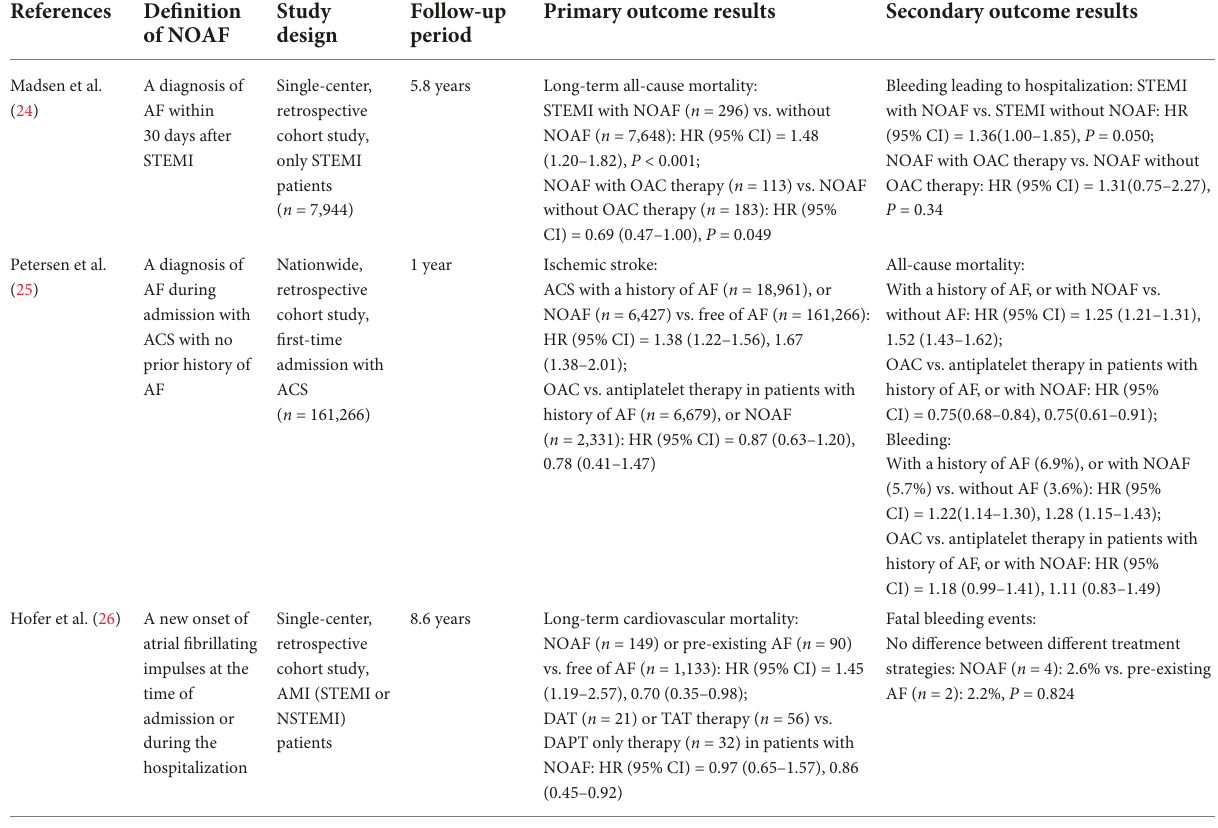
TABLE 1 Summary of the relevant studies of this